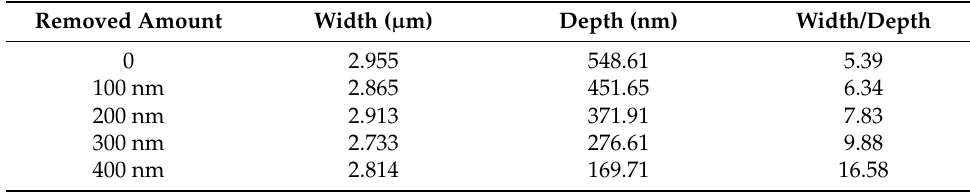
Table 1. Profile evolution of a V-bottom pit during MRF.